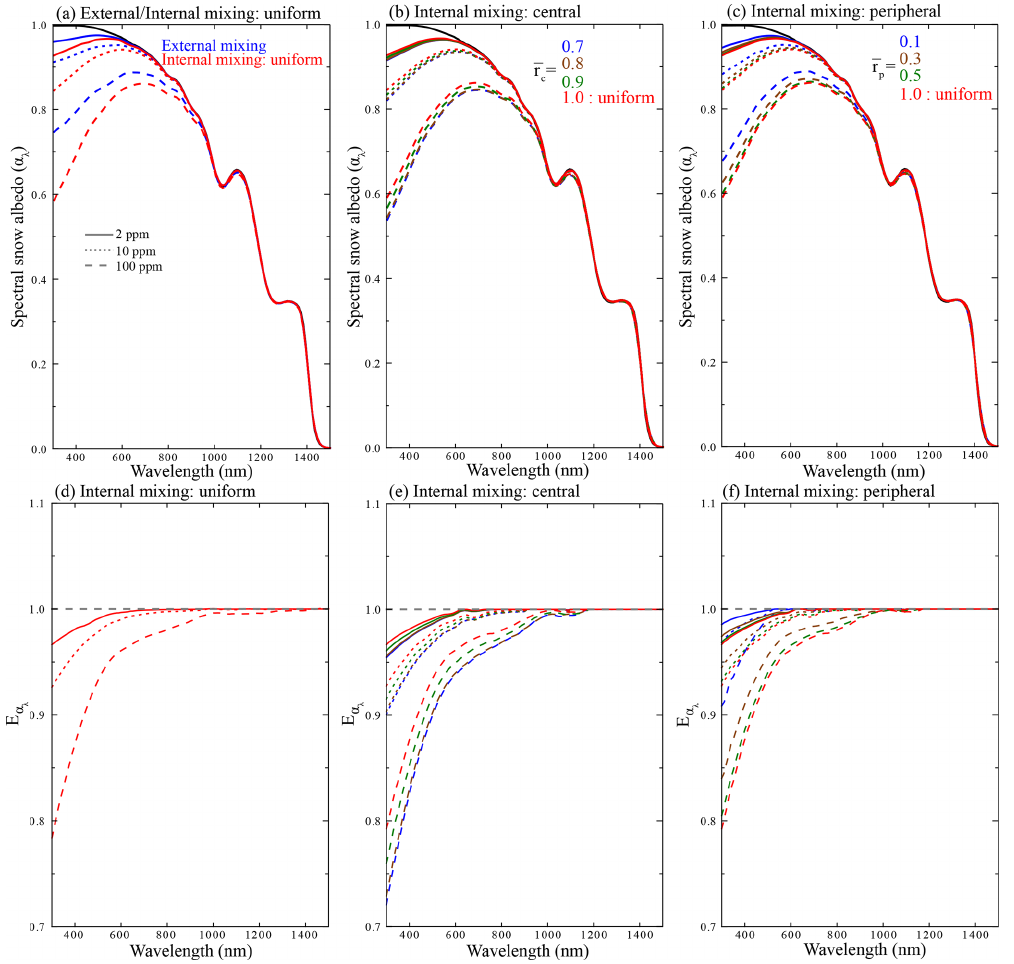
Figure 5. Same as Fig. 4, but for spectral snow albedo ( α λ